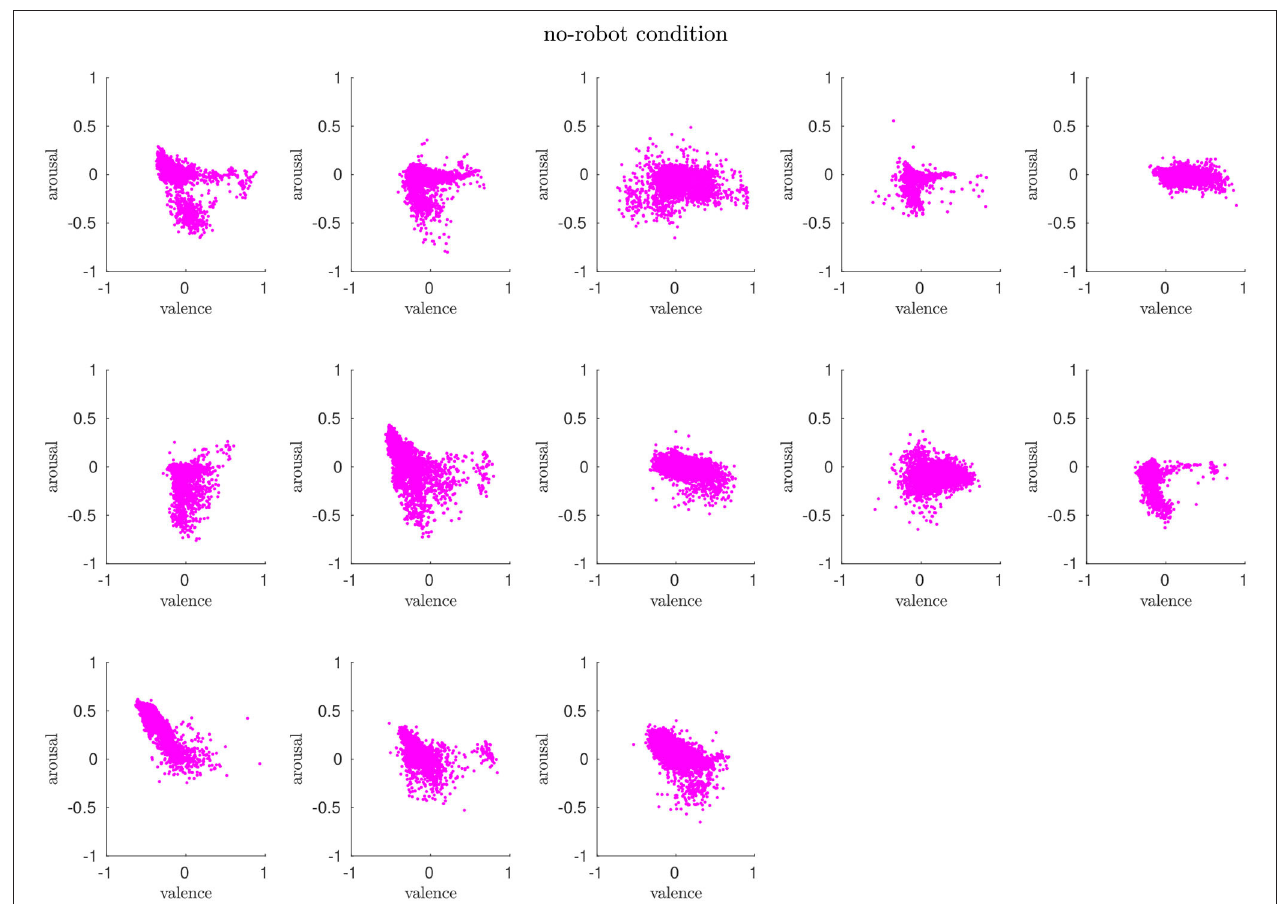
FIGURE 3 | In the no-robot condition, the participants’ affective states are mostly clustered around the neutral state and evolve around the horizontal axis